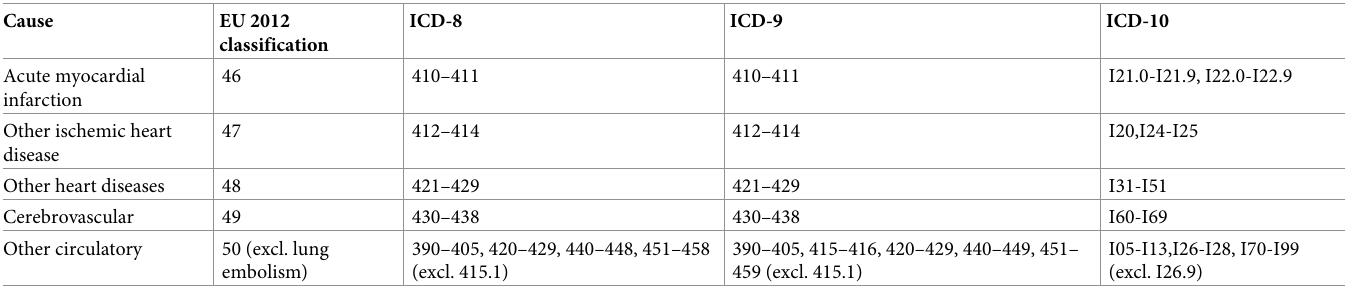
Table 3. Classification of underlying cardiovascular causes of